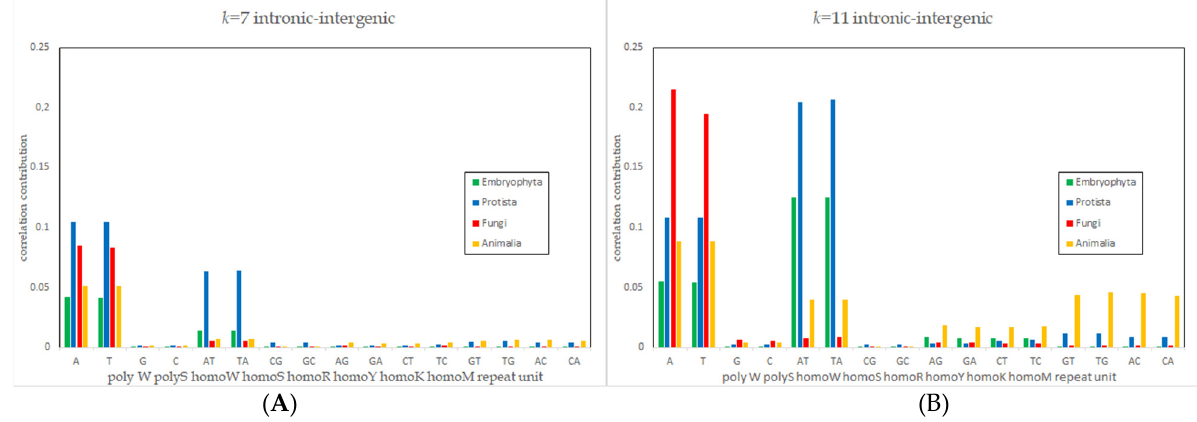
Figure 5. Correlation contributions of tandem repeat words with repeat length b =1 and b =2 for ( A ) k = 7 and ( B ) k = 11. Table 4. The correlation contributions for correlations between introns and intergenic regions for tandem repeat k -mer words with repeat unit length ≤ 2 bp for no and up to one allowed mismatch for k = 7 (top) and k = 11 (bottom) are shown. In rows with no mm—dark green; if in top 4—light green; if in top 16—bright green; if in top 128—orange; if in top 1600—red; if in